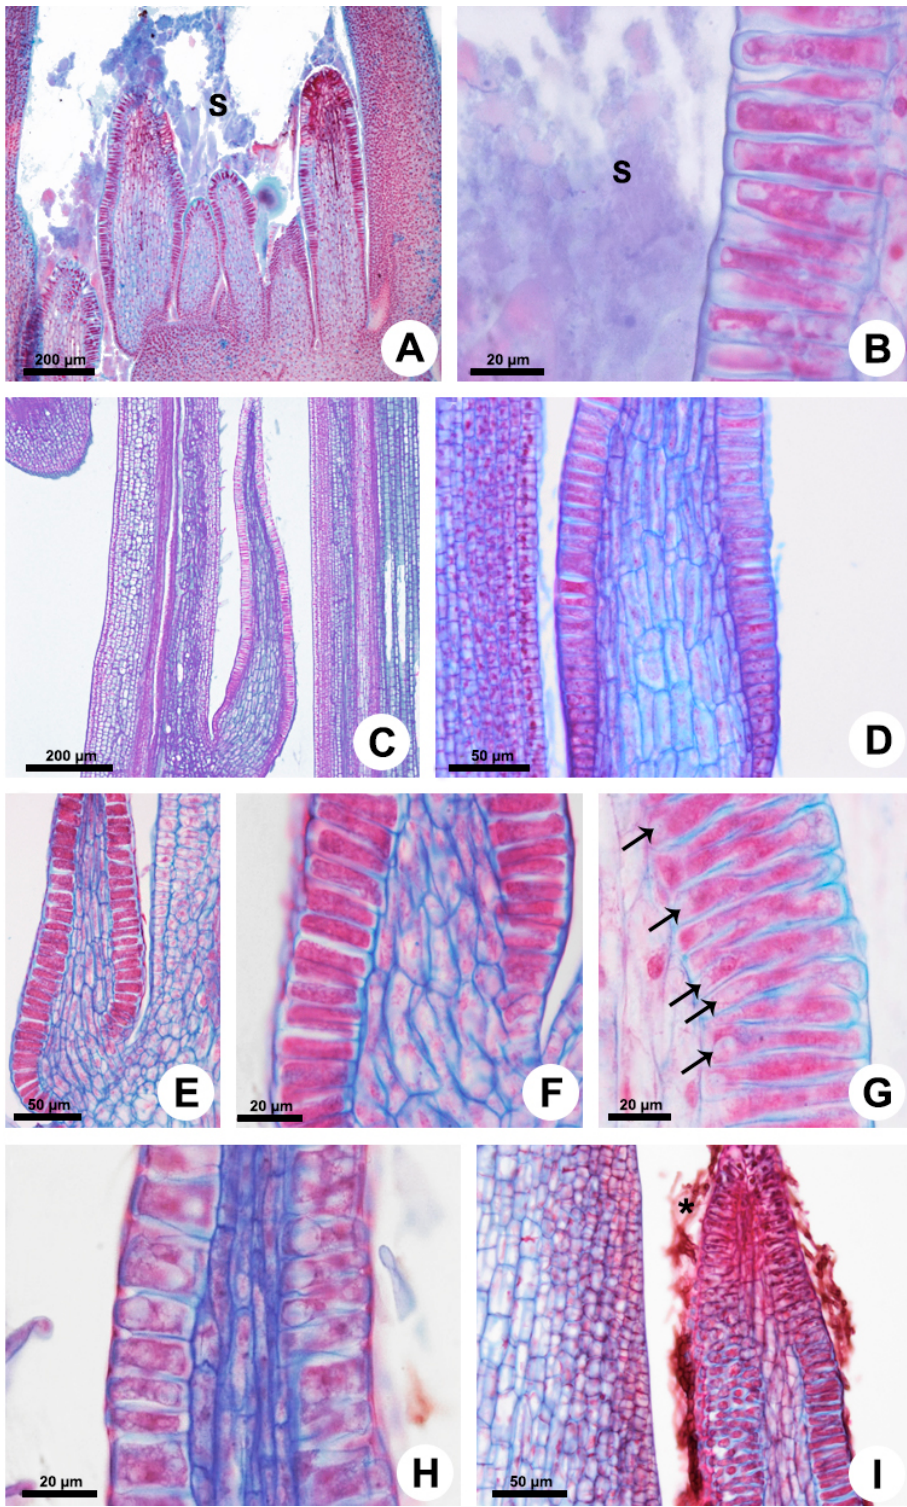
Figure 2. Anatomy of the colleters of Allamanda shottii ( A , B ), Blepharodon bicuspidatum ( C , D , G , H ), and Peplonia axillaris ( E , F , I ). Light microscopy. Longitudinal sections. ( A , C , E , H ) General view. ( B , D , F , G , I ) Detail of the secretory epidermis covering a parenchyma core. Note the presence of small vacuoles in the secretory cells ( G ) and the absence of vasculature. ( I ) Fungal hyphae (asterisk) on the mucilage colleter. Arrow = vacuole; S = secretion.